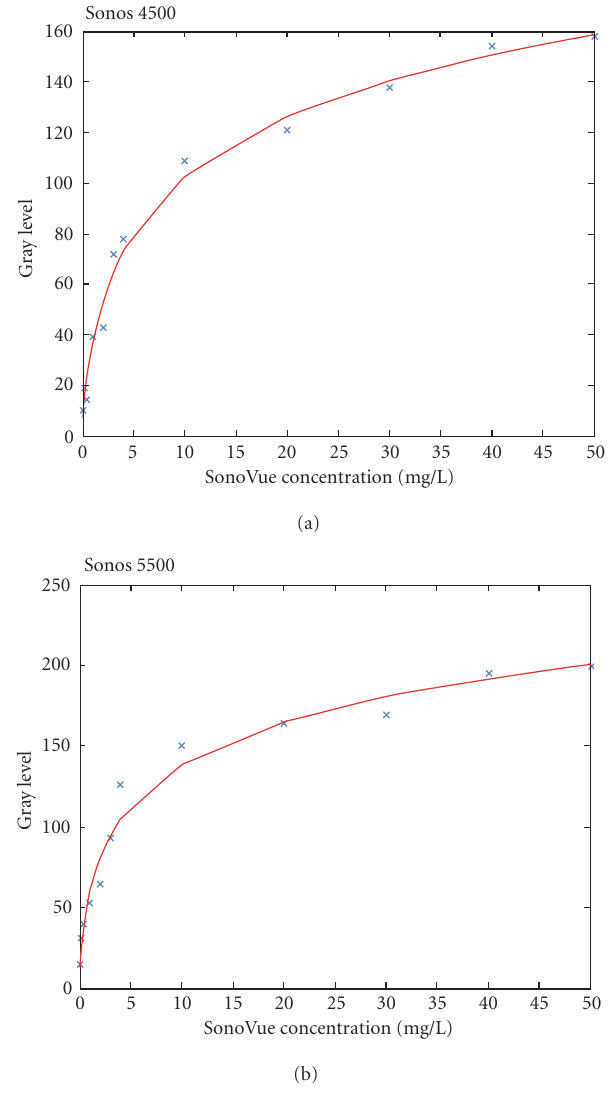
Figure 3: (a) The calibration fit for the Sonos 4500 scanner. The machine setting was MI = 0 . 3, FPS = 25, burst carrier frequency = 5MHz, gain = 44, and time gain = 50. The estimated parameters of the fitted model are a 0 = 83 . 1, a 1 = 1 . 6, and a 2 = 1 . 2. The determi- nation coe ffi cient is 0.99. (b) The calibration fit for the Sonos 5500 scanner. The machine setting was MI = 0 . 3, FPS = 25, burst carrier frequency = 5MHz, gain = 44, and time gain = 50. The estimated parameters of the fitted model are a 0 = 90 . 5, a 1 = 3 . 2, and a 2 = 1 . 4. The determination coe ffi cient is 0.98.